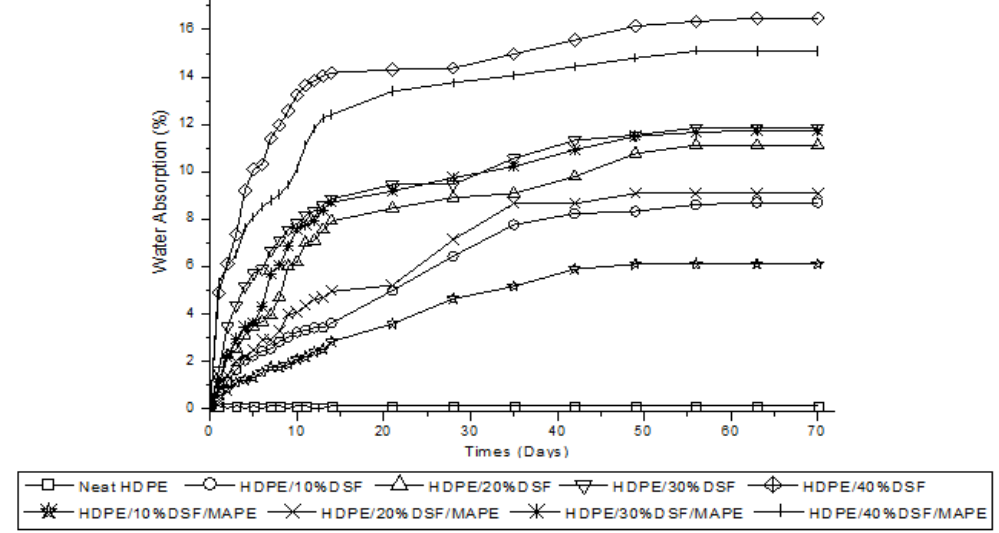
Figure 2: Percentage of water absorption of unreinforced HDPE, HDPE/DSF and HDPE/DSF/MAPE